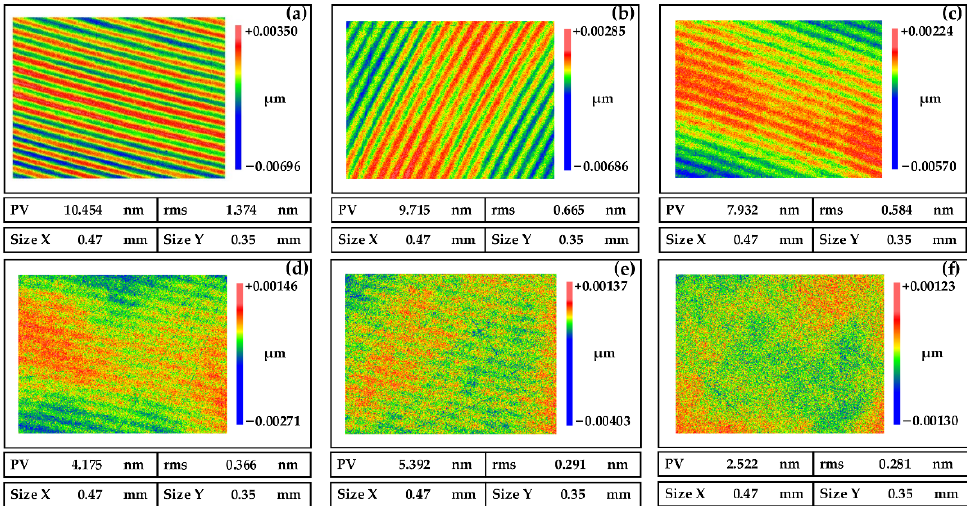
Figure 11. The roughness of the smoothing polishing process. ( a ) First polishing, ( b ) Second polishing, ( c ) Third polishing, ( d ) Fourth polishing, ( e ) Fifth polishing, and ( f ) Sixth polishing.